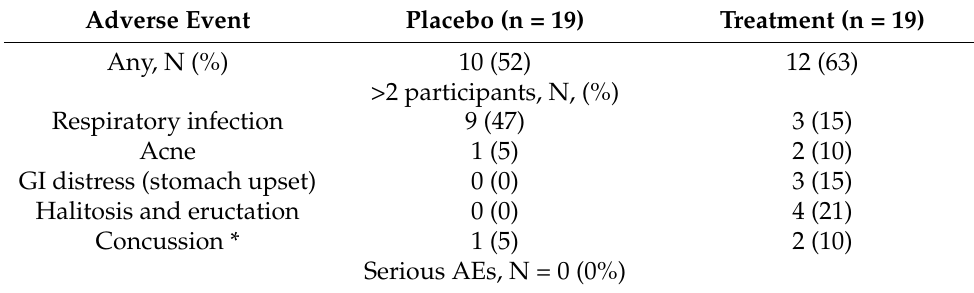
Table 1. Frequently reported adverse events by treatment group.